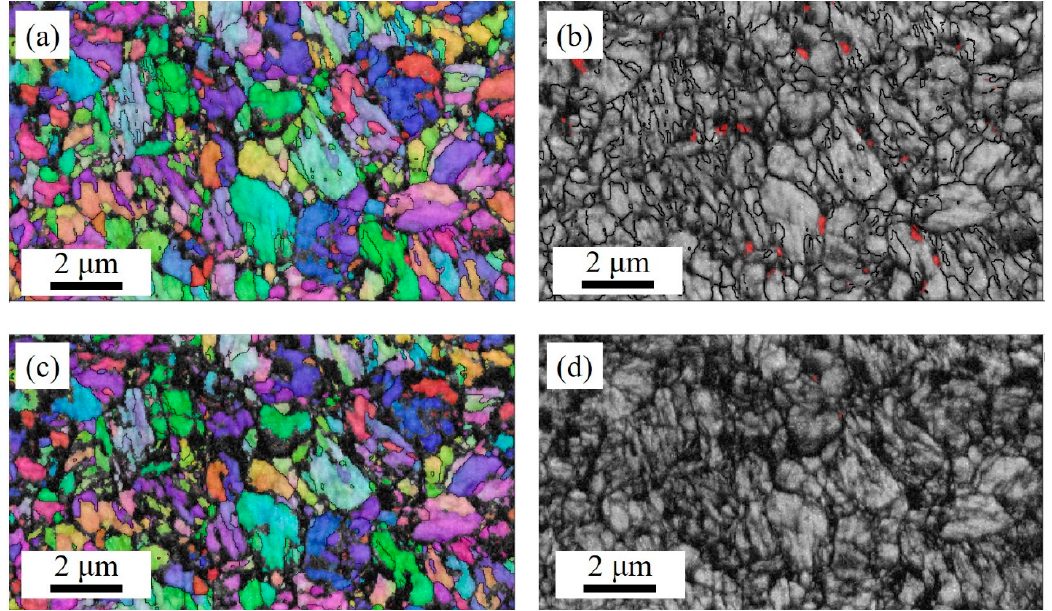
Figure 7. Images ( a , c ) are EBSD IPF-Z map of martensite and retained austenite with angle boundaries (with misorientations > 10°) of W-QT&P300 before and after deformation, respectively. Images ( b , d ) are the overlay map of band contrast with retained austenite in red color before and after deformation, respectively.